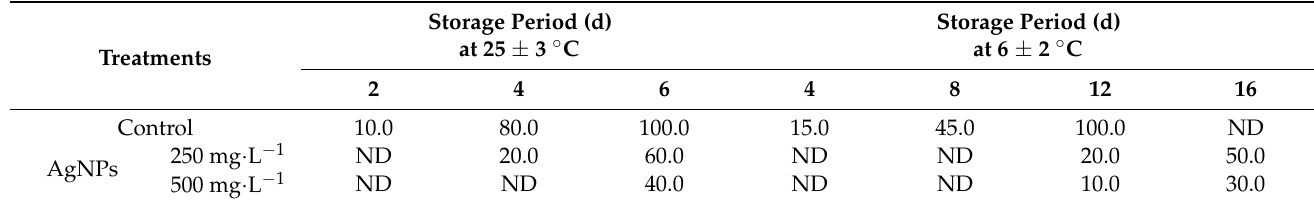
Table 3. The changes in the percentage of visual decay during storage.